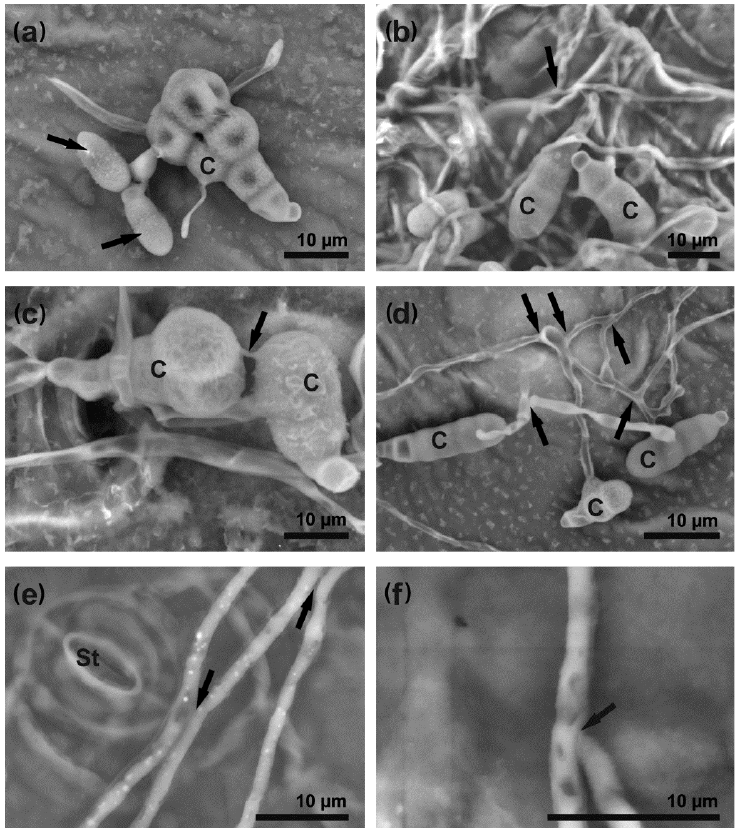
Figure 4. Alternaria brassicicola mycelium formation on B. oleracea leaves. The images were captured using SEM. ( a ) direct conidiation—new conidia (arrows) bud off from a mature conidium (24 hpi); ( b ) massive elongation and branching of hyphae (arrows) on the leaf surface (24 hpi); ( c , d ) conidial anastomosis tubes (CAT, arrows) form connections between conidia (24 hpi); ( e ) anastomoses (arrows) between hyphae (48 hpi); ( f ) fusion of hyphae (arrow) (48 hpi). Abbreviations: C—conidium, St—stoma.